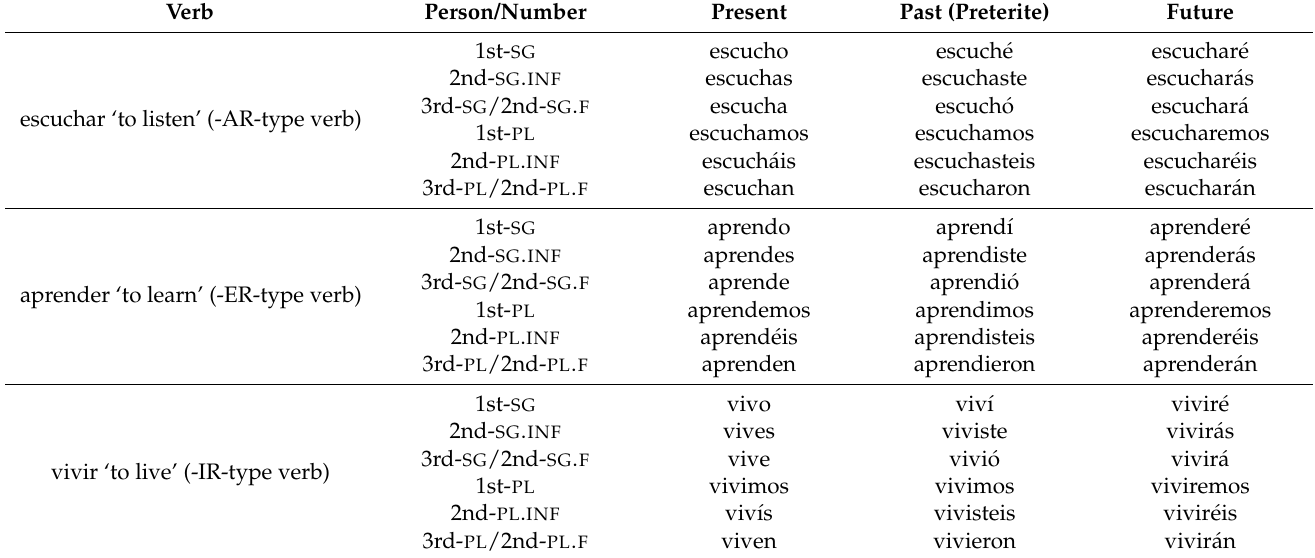
Table 1. Verbal Paradigm for Spanish Verb Classes in Present, Preterite, and Future Tenses. Verb Person/Number Present Past (Preterite)